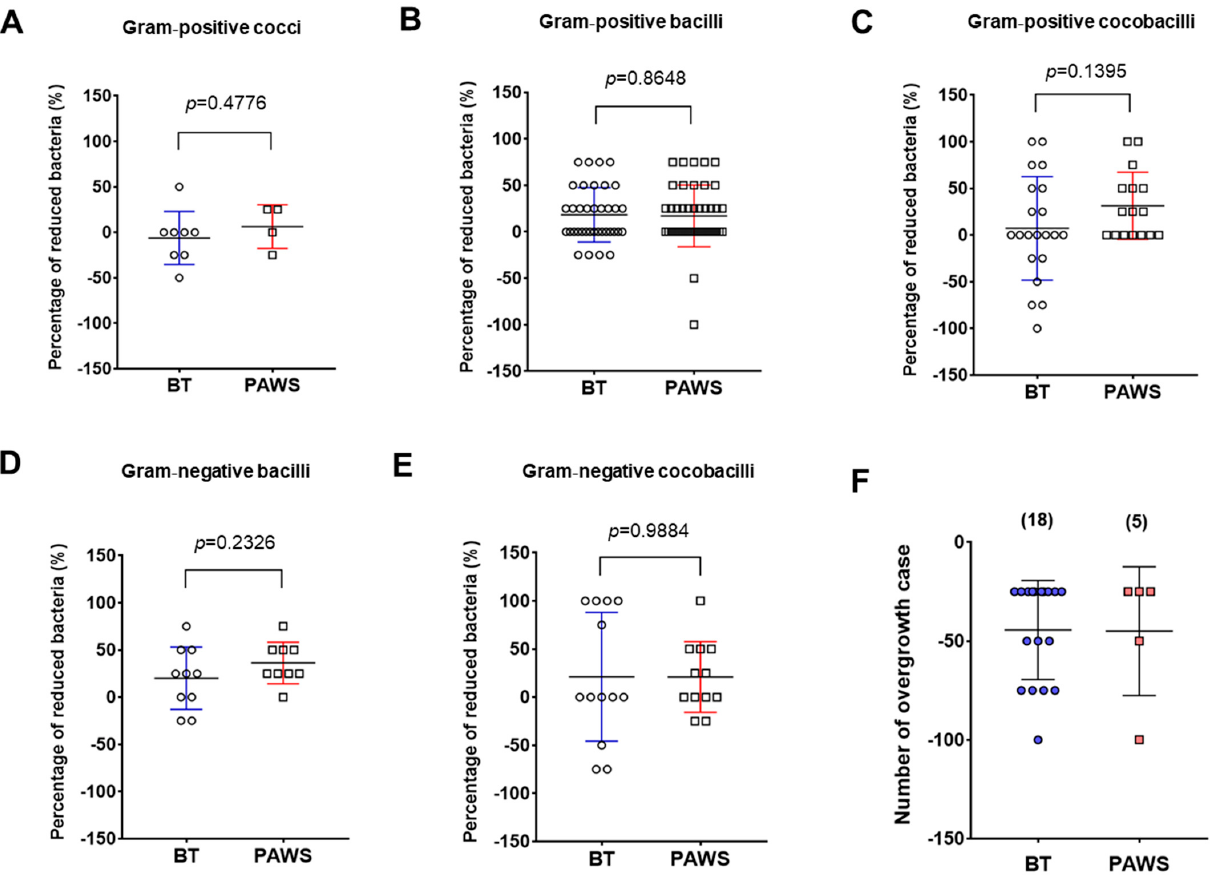
Figure 1. Beeswarm boxplot of the percentage of reduced bacteria, including Gram-positive cocci ( A ), Gram-positive bacilli ( B ), Gram-positive coccobacilli ( C ), Gram-negative bacilli ( D ), and Gram-negative coccobacilli ( E ), in betadine treatment (BT, blue) and plasma-activated water sprayed (PAWS, red) patients. ( F ) Beeswarm boxplot of the number of overgrowth cases after the application of BT or PAWS. All the results are expressed as means ± standard deviation (SD).